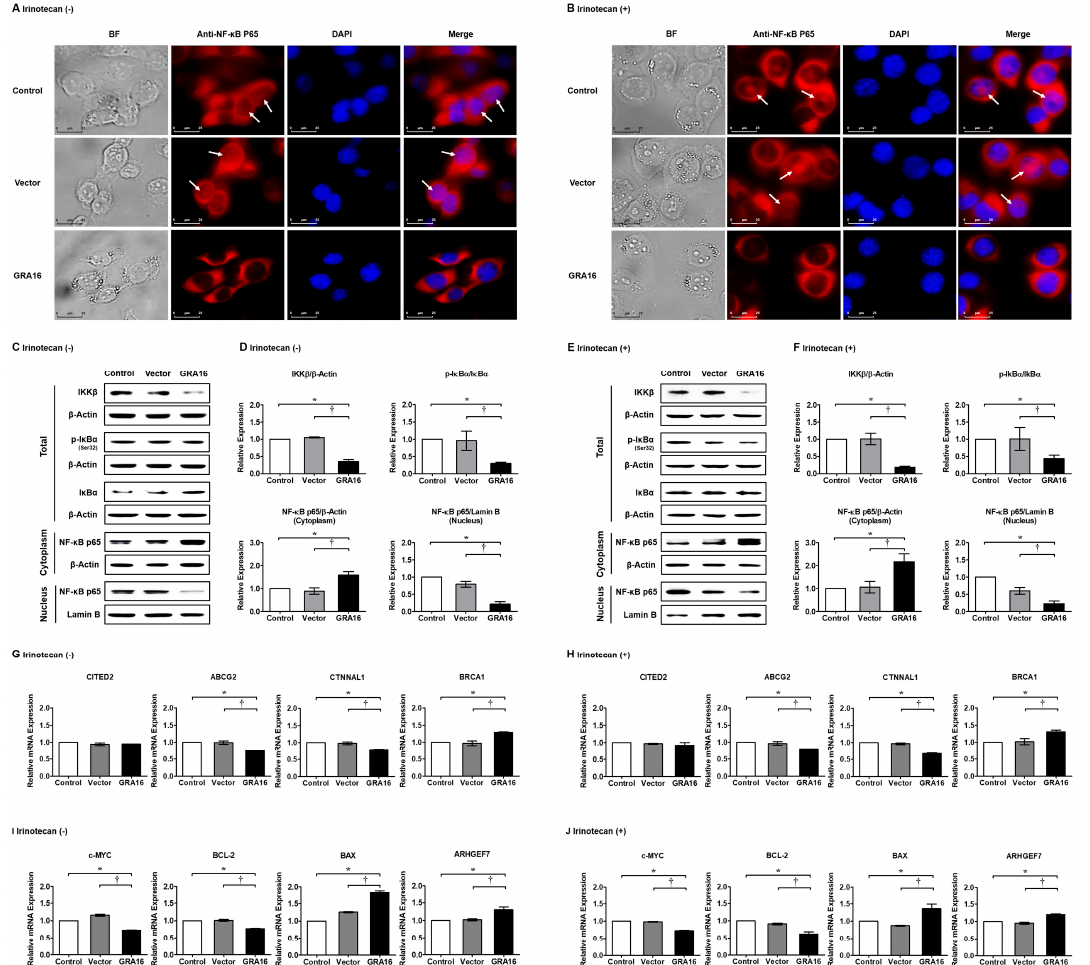
Figure 5. NF- κ B inhibition induced by GRA16 in NSCLC regardless of irinotecan treatment. Immunofluorescence assay (IFA) for NF- κ B expression in control, vector, and GRA16 cells without ( A ) and with ( B ) irinotecan treatment. BF: bright field, DAPI: nucleus staining. White arrows represent NF- κ B p65 protein in the nucleus. Scale bar represents 25 µ m. Western blots of IKK β , p-I κ B α , I κ B α , and NF- κ B p65 without ( C ) and with ( E ) irinotecan treatment and their relative expressions of protein in the cytoplasm and nucleus without ( D ) and with ( F ) irinotecan treatment. Changes in drug resistance ( CITED2 , ABCG2 , and CTNNAL1 ) and sensitivity ( BRCA1 ) markers without ( G ) and with ( H ) irinotecan treatment. Changes in NF- κ B target genes related with antiapoptosis ( c-MYC and BCL-2 ) and proapoptosis ( BAX and ARHGEF7 ) markers without ( I ) and with ( J ) irinotecan treatment. * significant at p < 0.05 between control and GRA16 cells; † significant at p < 0.05 between vector and GRA16